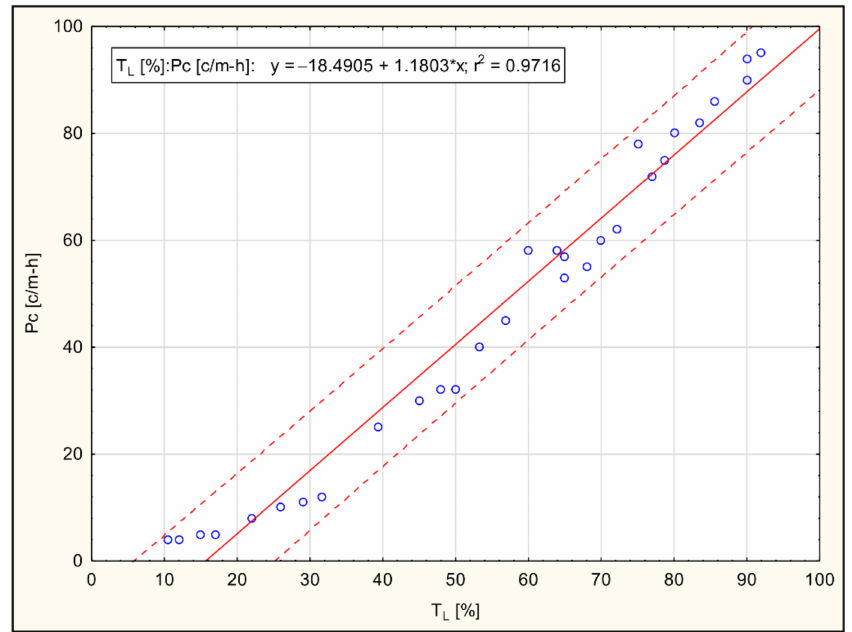
Figure 3. Changes in the milkman’s work productivity (P c ) with an increase in the technological index level (T L